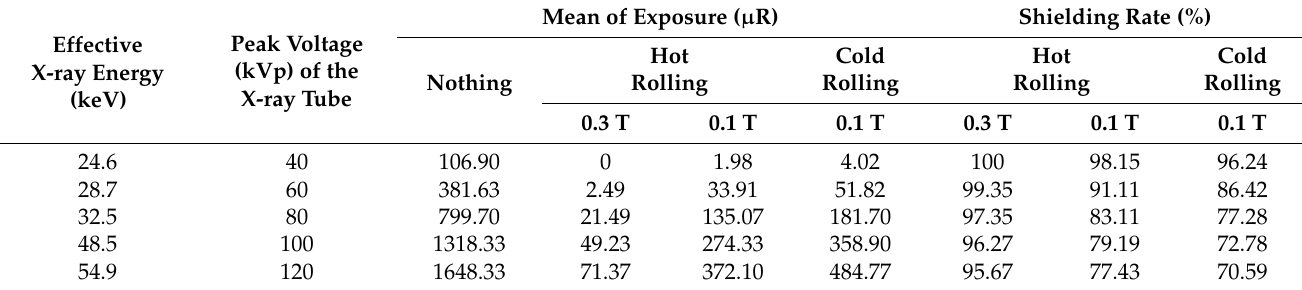
Table 1. Shielding performance according to the shielding plate manufacturing process.